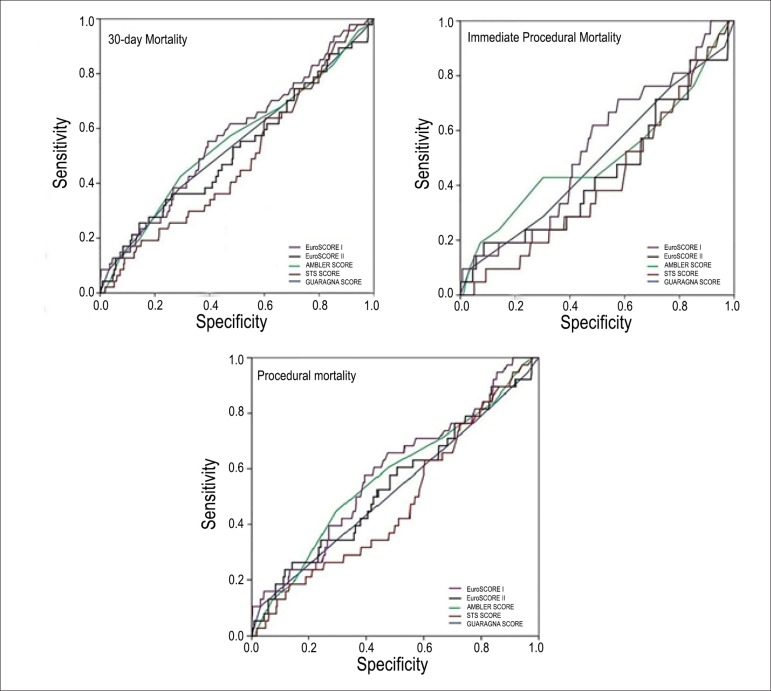
ROC curves for the outcomes assessed using the different surgical risk scores.